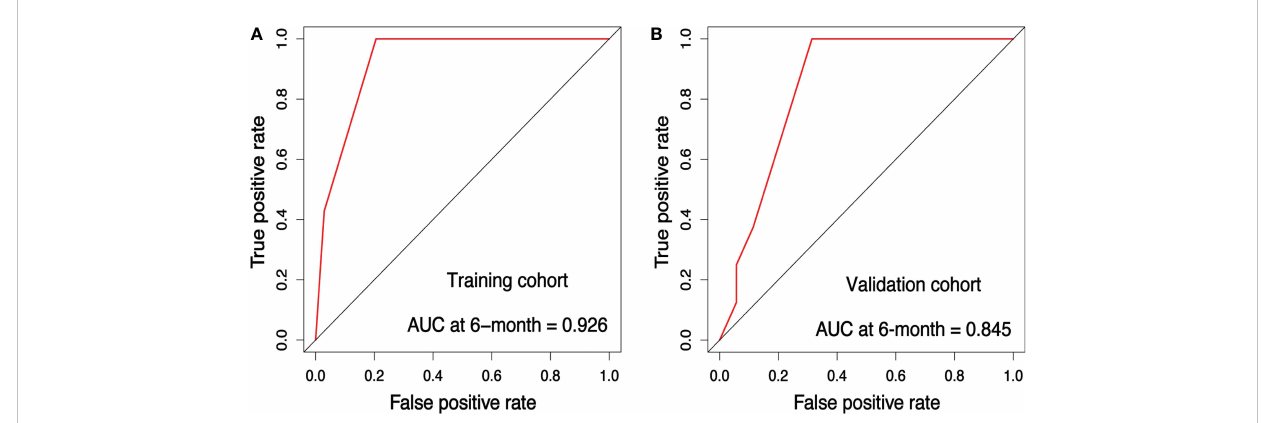
FIGURE 5 Receiver operating characteristic (ROC) analysis for the training and validation cohort. ROC curve for the prediction model (A) in the training cohort (B) in the validation cohort.